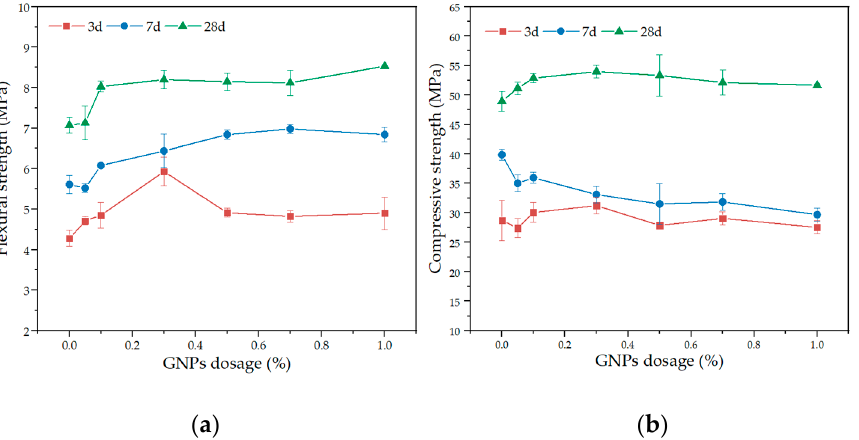
Figure 12. Mechanical properties of GNPs cement mortar; ( a ) flexural strength; ( b ) compressive strength.